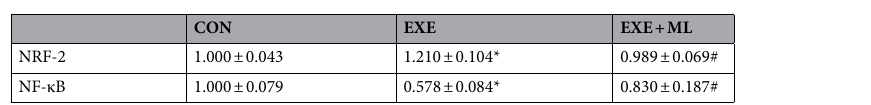
Table 6. NF-κB and NRF-2 protein expression of NRK-52E cell. *Significantly different from CON ( p < 0.05), #Significantly different from EXE ( p < 0.05).